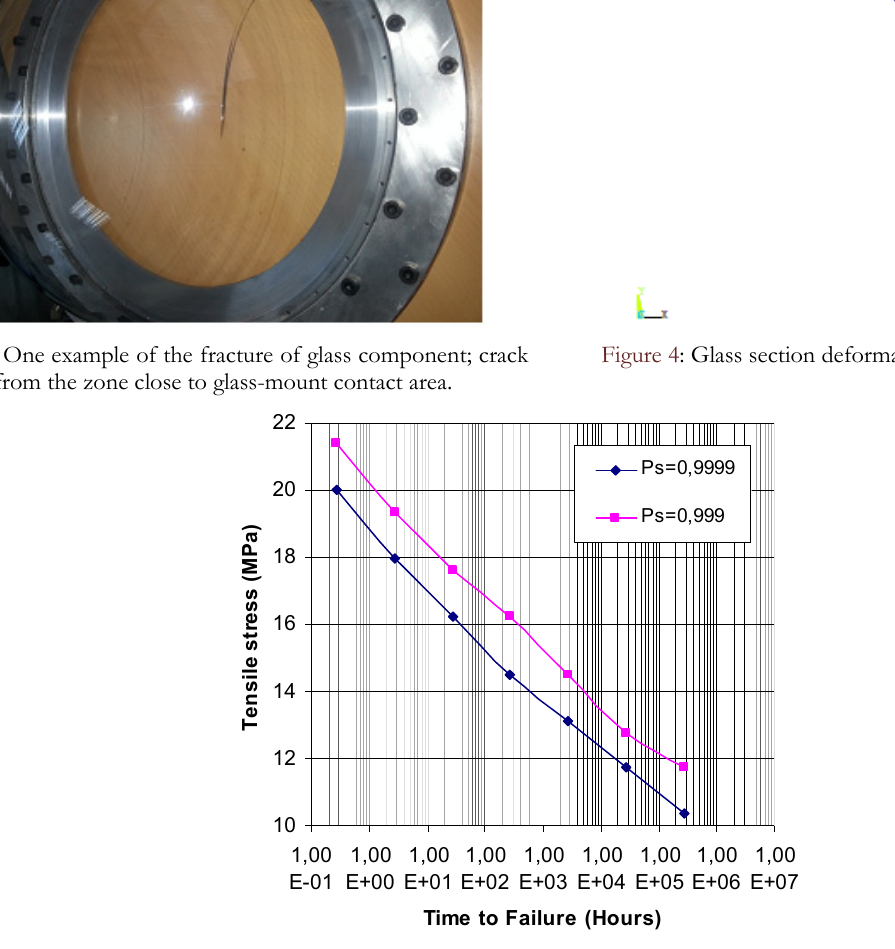
Figure 5: Design strength diagram, the time-to-failure versus the maximum tensile stress curves as a function of the probability of survivability (or reliability) P s